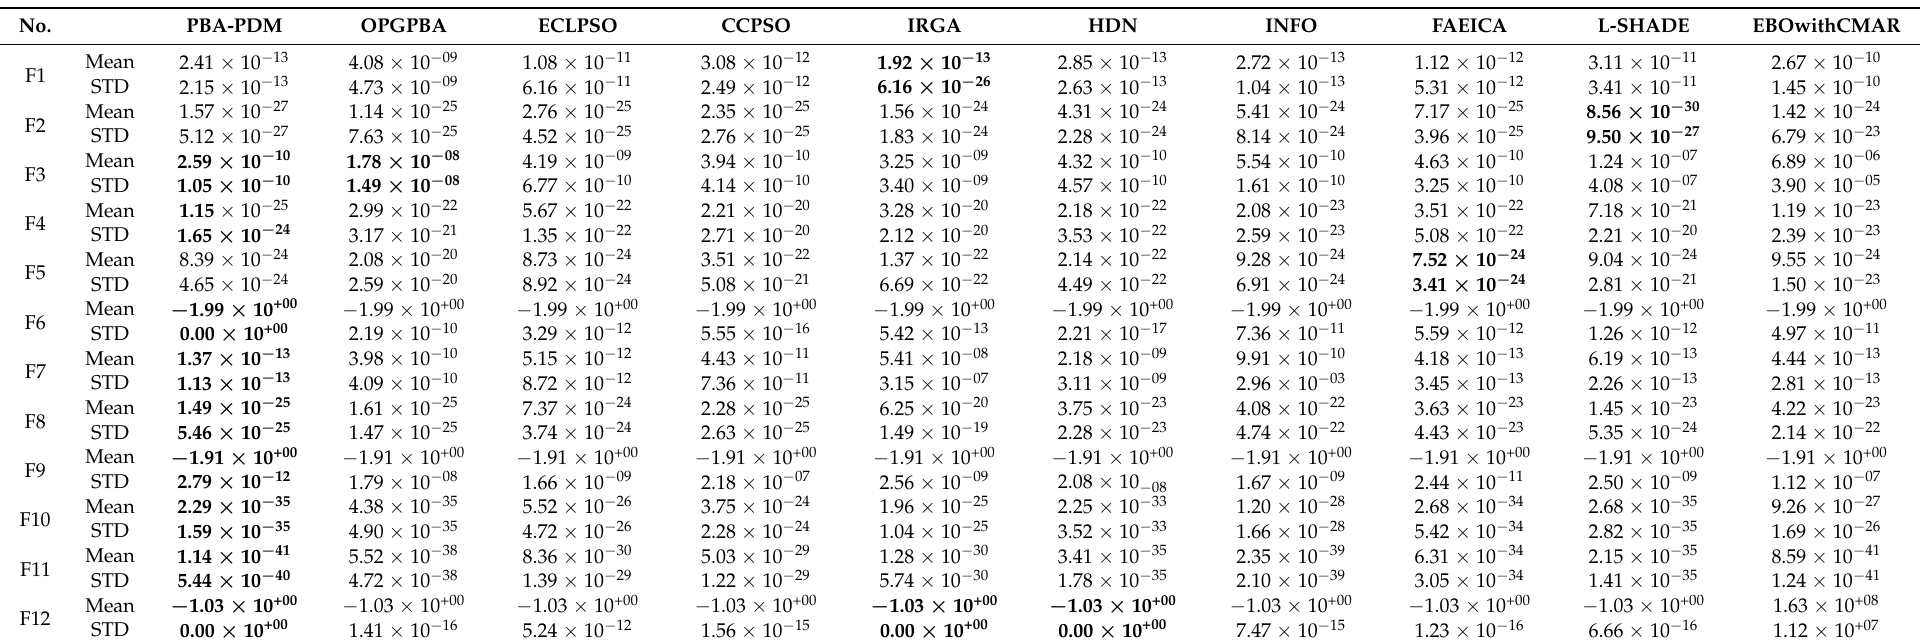
Table 4. Statistical results of the unimodal test